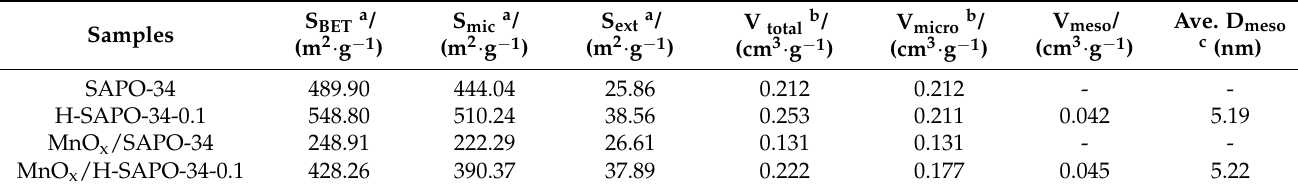
Figure 6. N 2 adsorption–desorption isotherms ( a ) and pore size distributions ( b , c ) of the synthesized catalysts. Table 1. Structural properties of the Table 1. Structural properties of the samples.